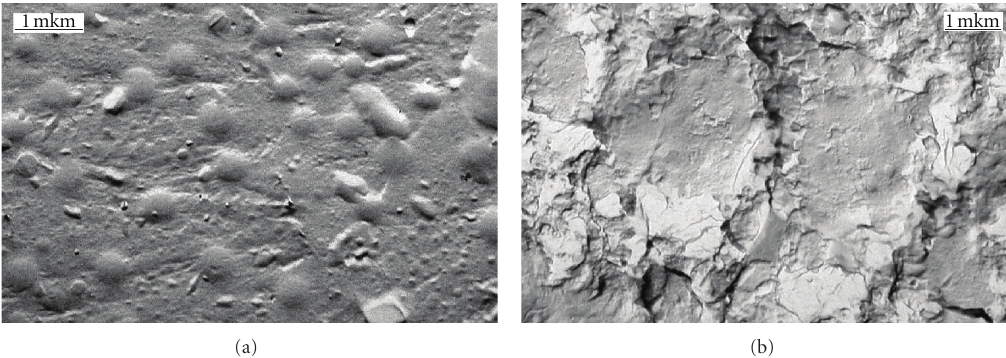
Figure 4: SEM micrographs (magnification × 1000) of quenched (a) and annealed (b) hot-pressed films of the CPL1/130 ◦ C blend.